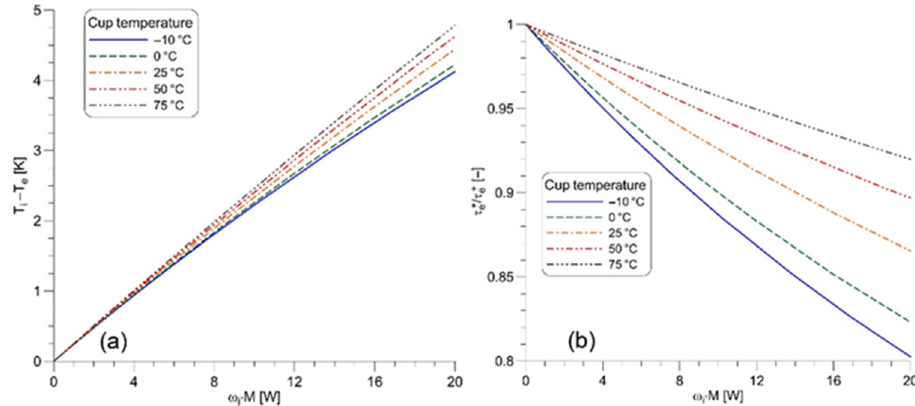
Figure 4. Effect of the viscous heating in the measurement of the base oil 10W40 on: ( a ) temperature difference in the measuring gap; ( b ) the shear stress at the surface of the outer cylinder.